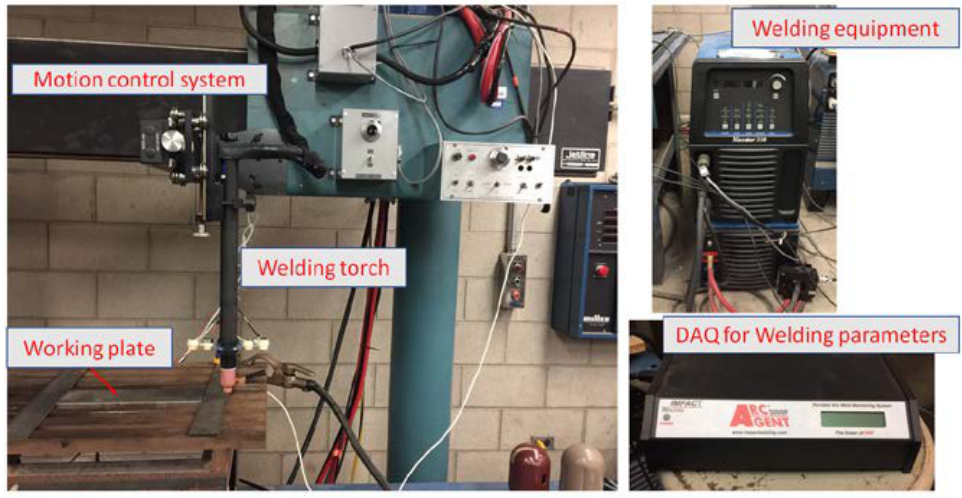
Figure 1. The test setup for the welding process.